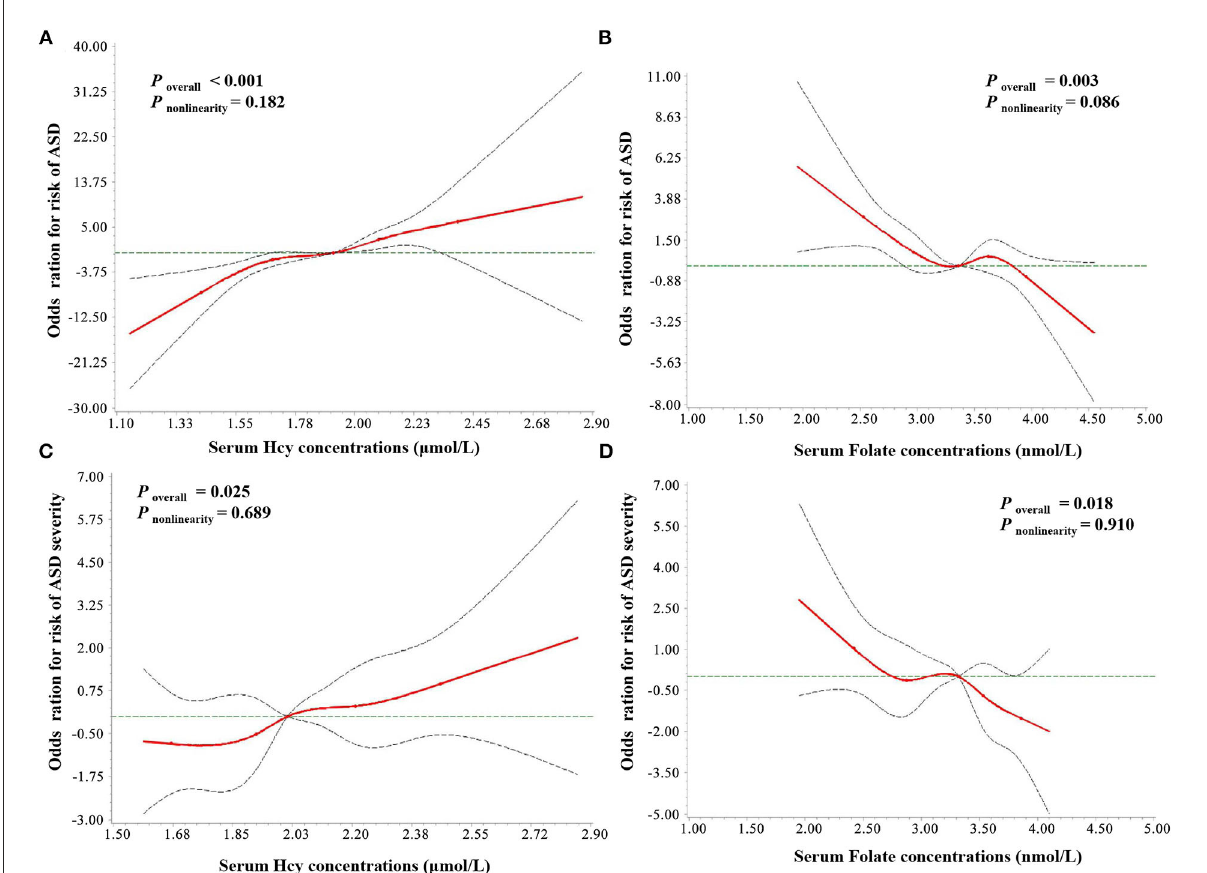
FIGURE6 RCS regression analysis of serum Hcy and folate concentrations with ASD risk and severity. The risk estimates for ASD risk (A,B) and severity (C,D) were adjusted for age, sex, BMI, picky eating, use of vitamins, and the other two metabolites. Lines represent adjusted odds ratios (solid red lines) and 95% CIs (long dashed lines) based on the RCS models for the ln-transformed concentrations of serum Hcy and folate. The reference values were set at the 25th percentiles, and the knots were set at 5th, 25th, 50th, 75th, and 95th percentiles of the ln-transformed concentrations, respectively. Hcy, homocysteine; VitB12, vitamin